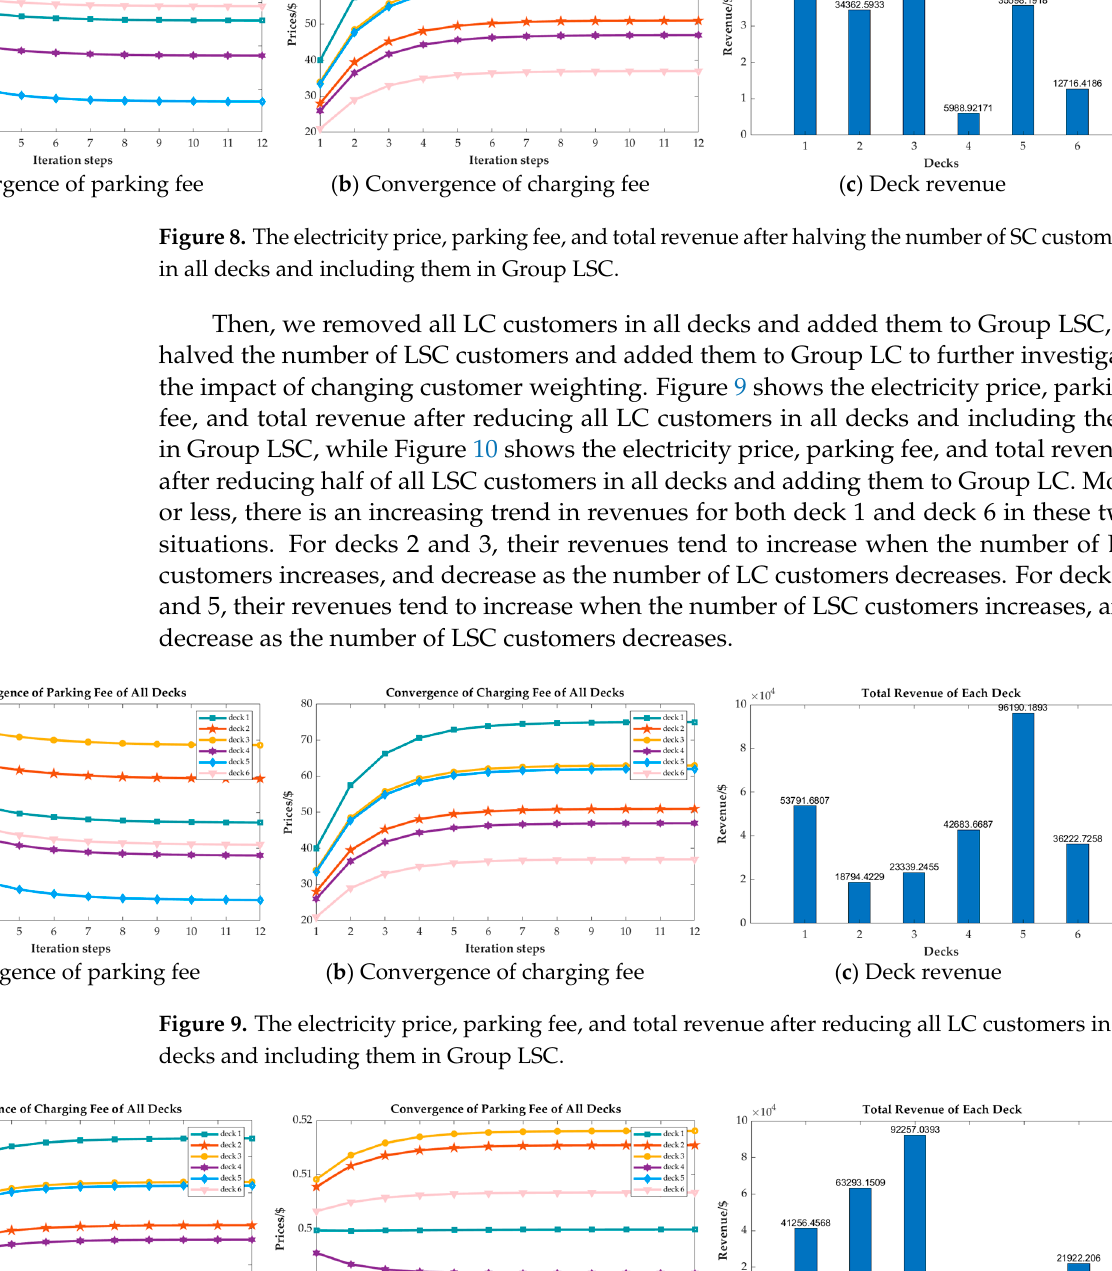
( c ) Deck revenue Figure 6. The charging price, parking fee, and total revenue after the number of LC customers in deck 6 was reduced to zero. ( a ) Convergence of parking fee ( c ) Deck revenue Figure 7. The electricity price, parking fee, and total revenue after halving the number of SC cus- tomers in all decks and including them in Group LC. Then, we removed all LC customers in all decks and added them to Group LSC, or halved the number of LSC customers and added them to Group LC to further investigate the impact of changing customer weighting. Figure 9 shows the electricity price, parking fee, and total revenue after reducing all LC customers in all decks and including them in Group LSC, while Figure 10 shows the electricity price, parking fee, and total revenue